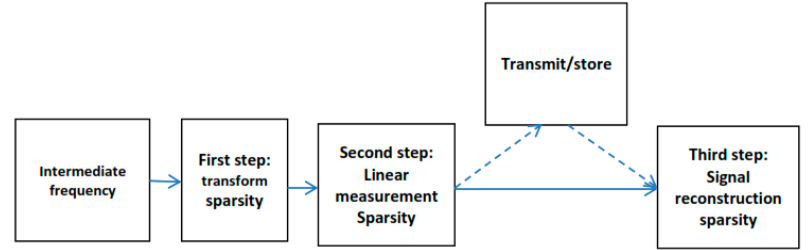
Figure 4. Signal processing based on compressed sensing.